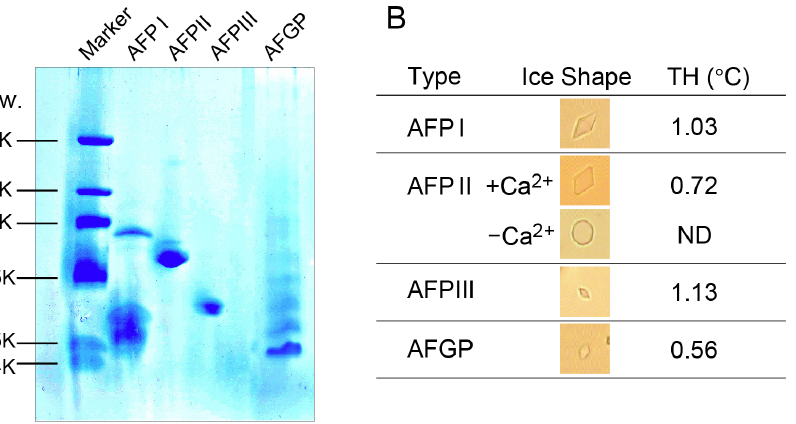
Figure 2. Analyses of purity and structural integrity of the AFP samples. A. Electrophoretogram of AFPI–III and AFGP samples provided by Nichirei Foods Inc. on 16.5% tricine-SDS-PAGE. The AFGP sample only contains molecules less than 10 kDa owing to a filtration step. B. The shape of an ice crystal and TH activity obtained for each AFP sample dissolved into the Euro-Collins solution. All protein concentrations were 10 mg/ml.